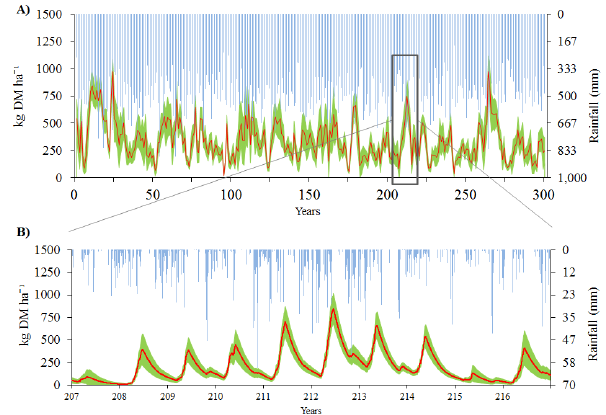
Fig. 8. Simulated average pasture production and precipitation at site 1; (A) at the annual timescale for 300years; (B) for ten years at the daily timescale (the green shade represents ± 1 standard devia- tion of pasture production, and the blue bars is the